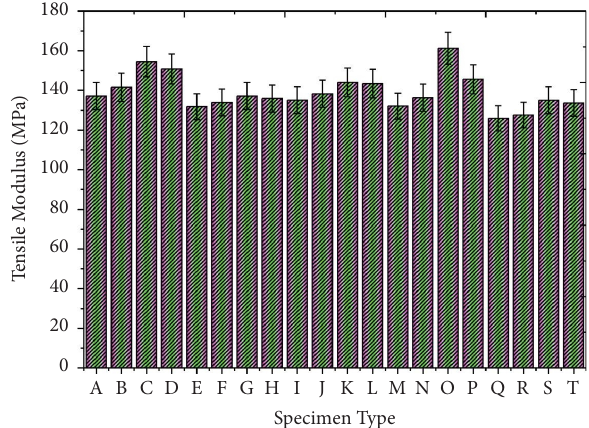
2 O 3 /jute/hemp/